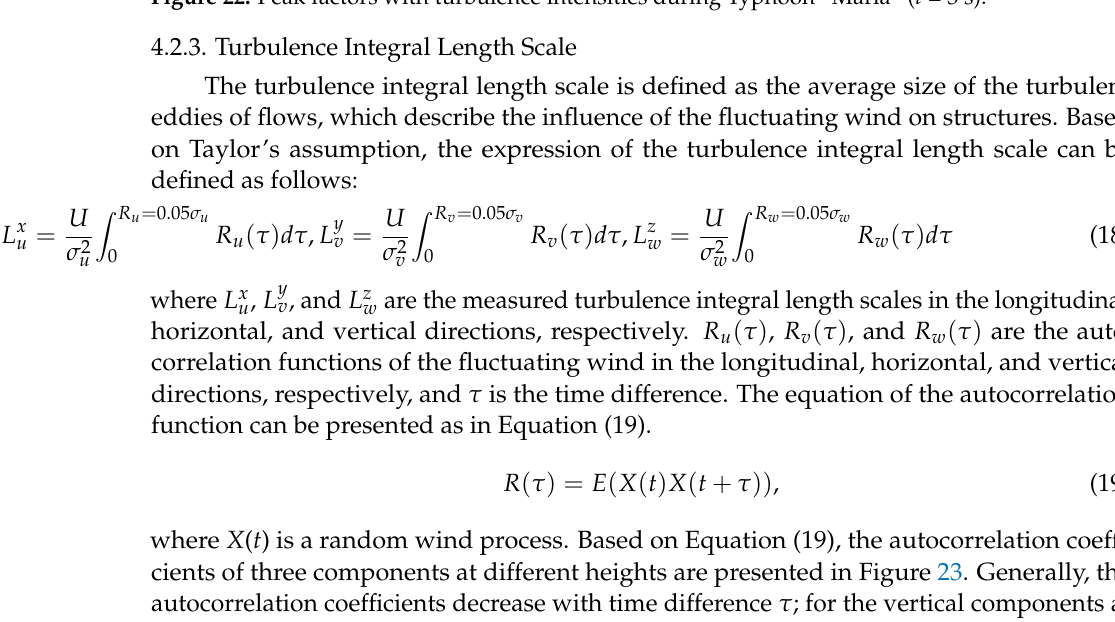
Figure 22. Peak factors with turbulence intensities during Typhoon “Maria” ( t = 3